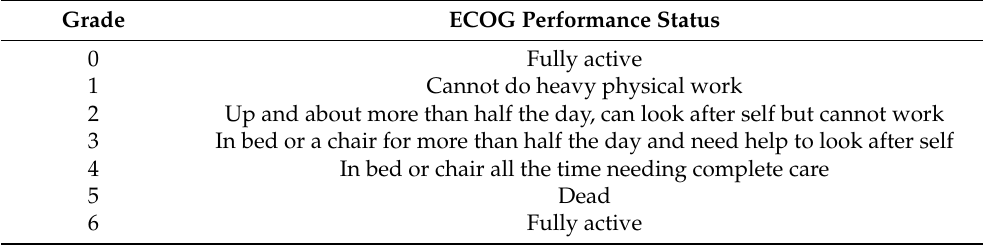
Table 2. Eastern Cooperative Oncology Group Performance Status